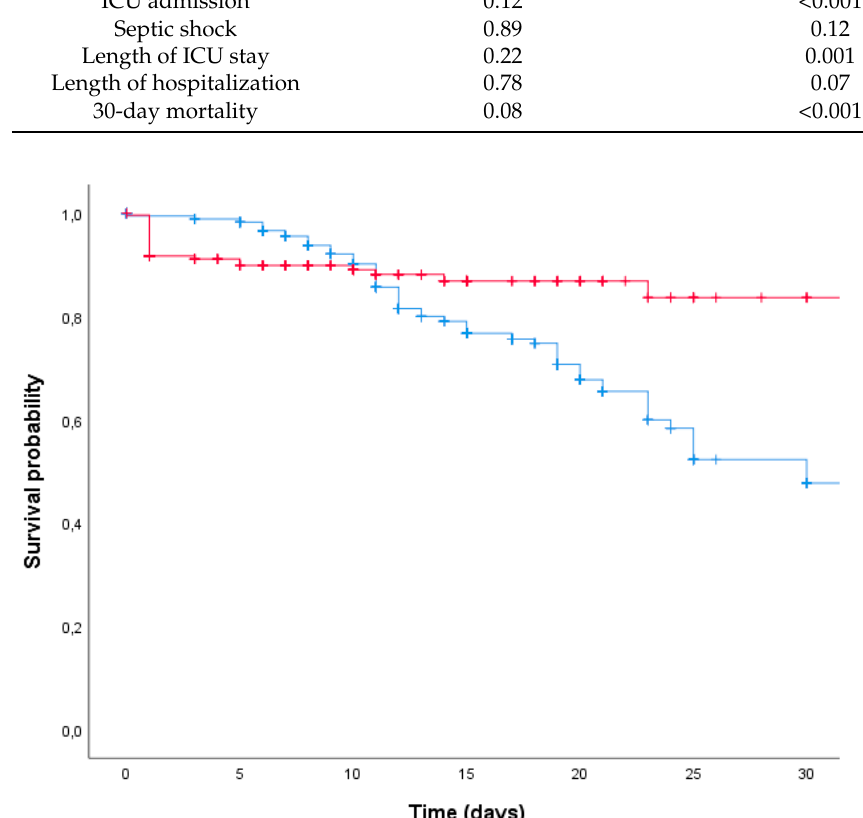
Figure 1. Kaplan–Meier curves on 30-day survival of patients when treated with early effective therapy (red line) or delayed effective therapy (blue line) ( p < 0.001). therapy (red line) or delayed effective therapy (blue line) (